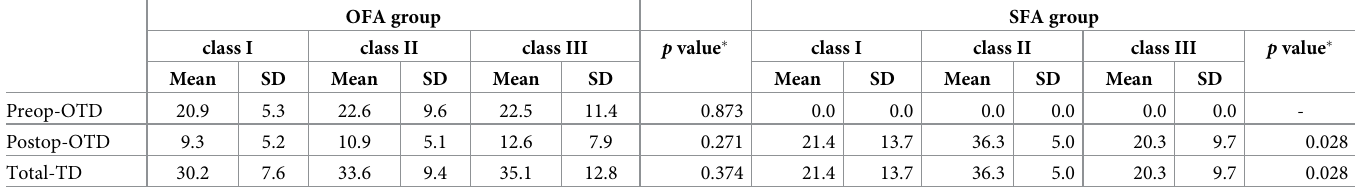
Table 9. Comparison of treatment durations among skeletal classifications in orthodontics-first approach and surgery-first approach